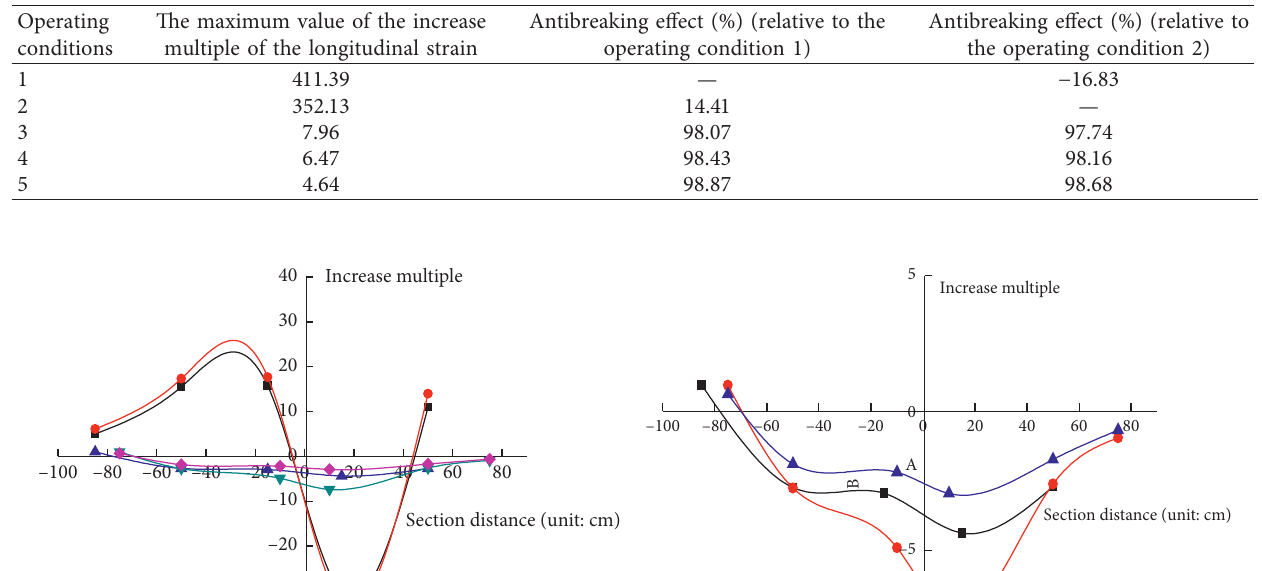
Table 5: Antibreaking effect of longitudinal